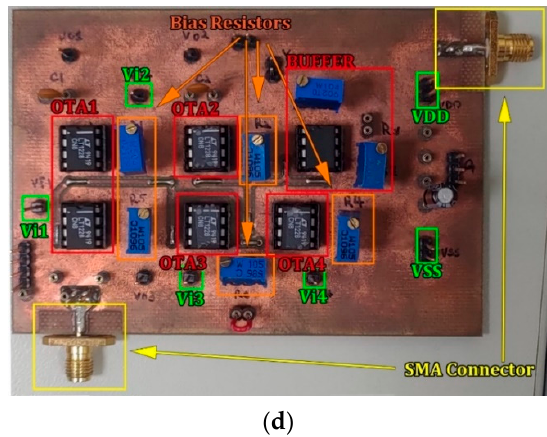
Figure 30. Experimental test bench for the versatile VM biquad filter and quadrature oscillator: ( a ) the measured gain and phase responses of the BP filter; ( b ) the measured time-domain of the BP filter in the center frequency of 144.69 kHz; ( c ) the measured frequency spectrum analysis of the BP filter of Figure 30b; and ( d ) the discrete element prototype board.